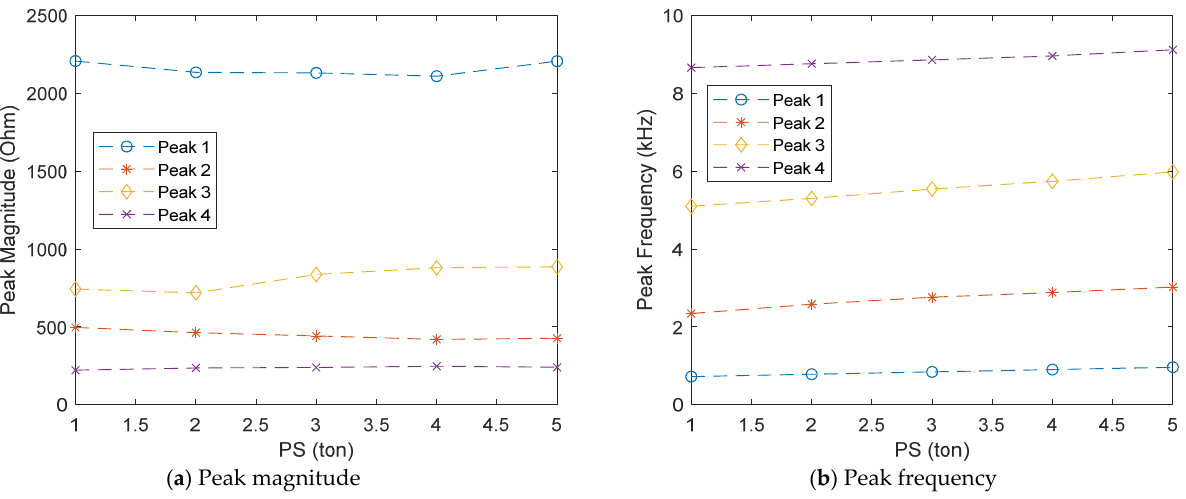
Figure 8. Changes in magnitudes and frequencies of the resonant peaks.